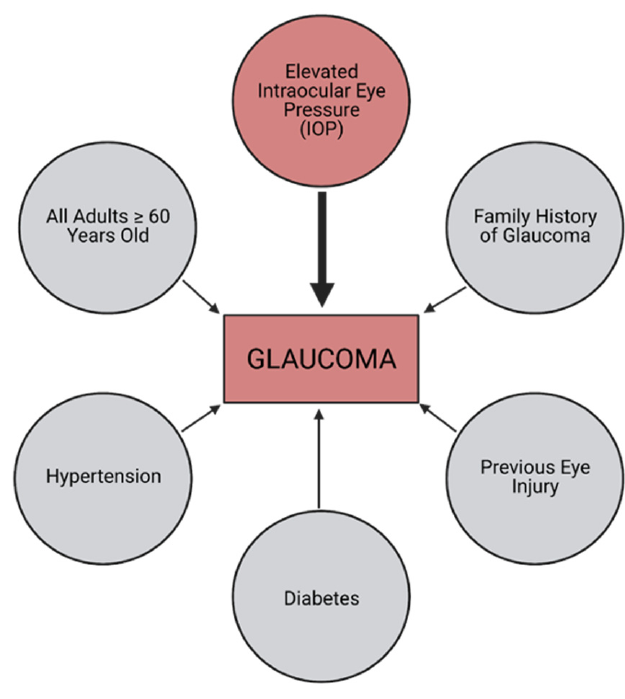
Figure 3. Common risk factors for developing glaucoma.